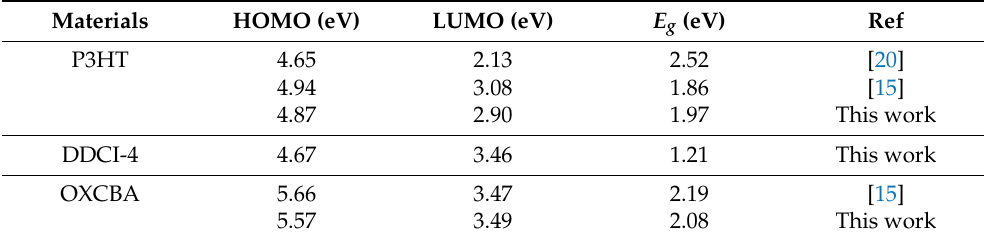
Table 2. Comparison of HOMO, LUMO and E g values obtained from previous literature and this work.